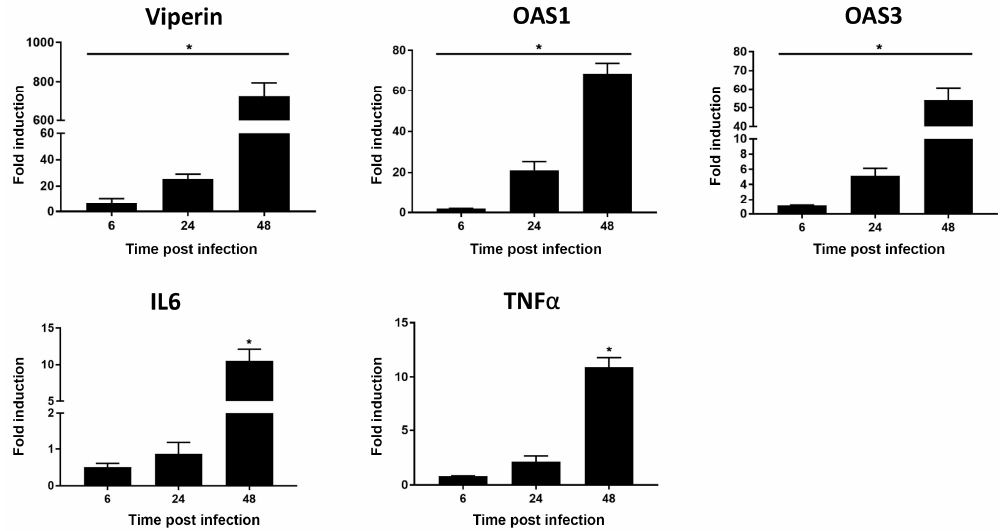
Figure 3. Regulation of immune genes in MAYV-infected human chondrocytes. Primary HC were exposed to MAYV at a MOI of 1, and mRNA levels of the corresponding genes were quantified by real-time PCR. Fold change compared to mock-infected cells are shown. Data are representative of three independent experiments, each performed in triplicate (error bars represent SEM). Differences between data were analyzed using the Wilcoxon–Mann–Whitney test. p values of < 0.05 were considered significant (*).